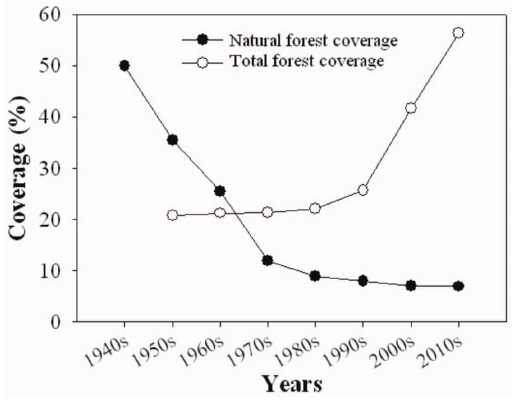
Figure 1. Total forest coverage and natural forest coverage on Hainan Island from 1940s to 2010s. Data are from the National Forest Resources Inventory.